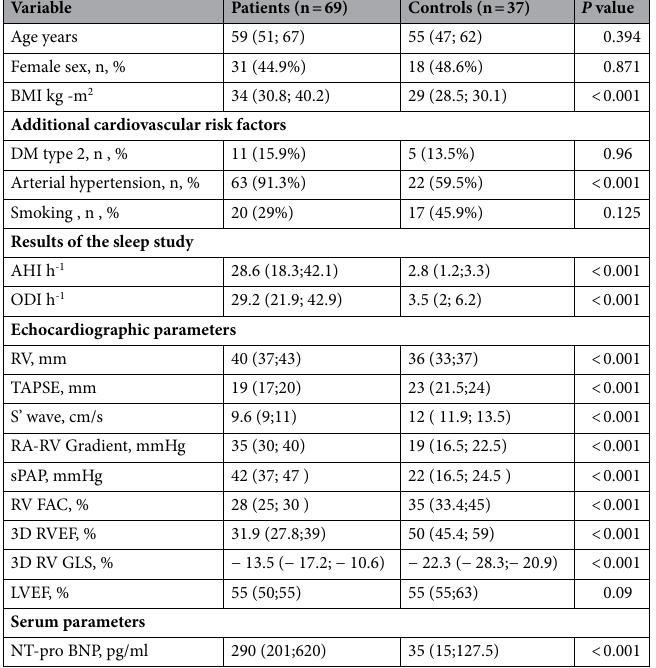
Table 1. Baseline characteristics of randomized patients. Data are presented as median (25–75 percentiles) and n (%); BMI: body mass index, AHI: apnea–hypopnea index, ODI, overnight desaturation index, DM: